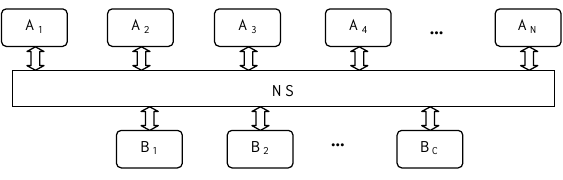
Fig. 4. Tactical reconnaissance agents system organization.